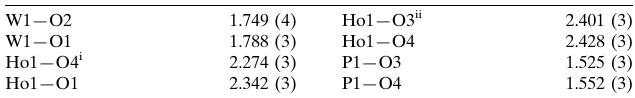
Selected bond lengths (A˚